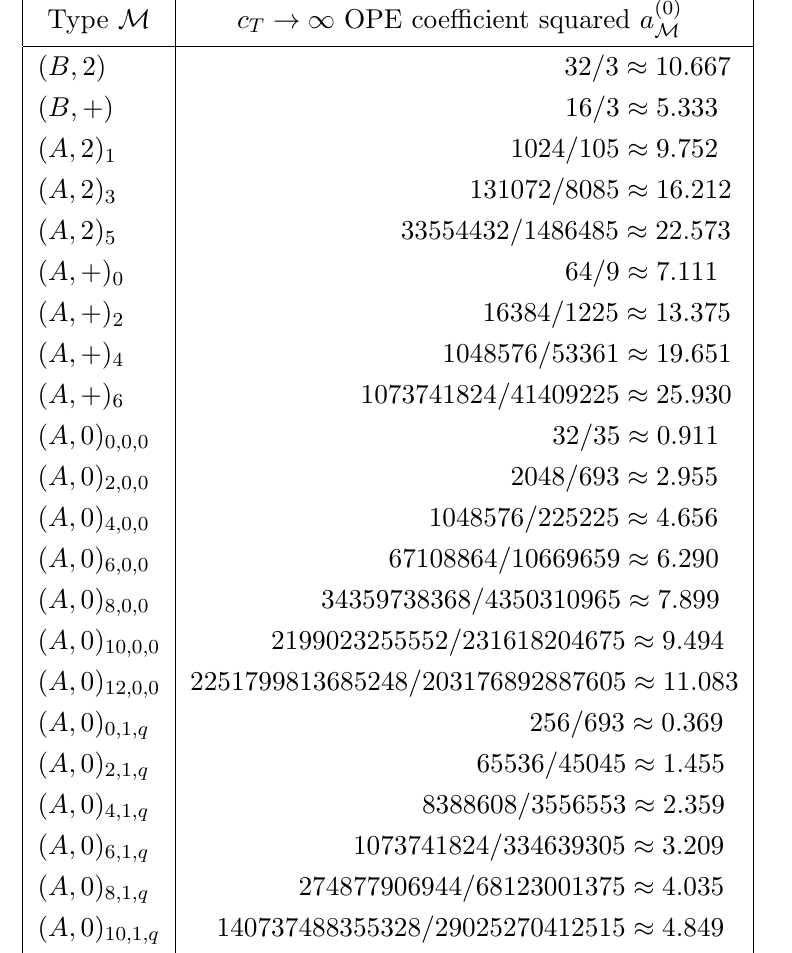
Table 4 . Values of OPE coe(cid:14)cients squared a (0) O Stress (cid:2) O Stress